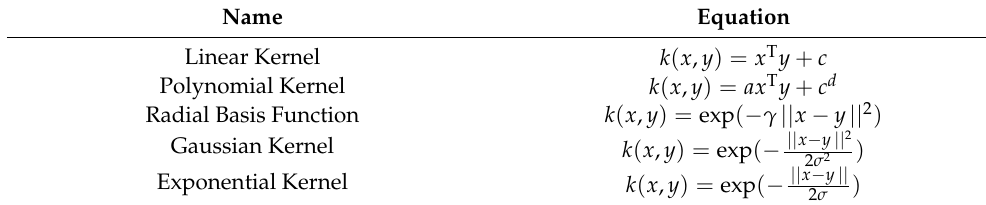
Table 1. Some popular kernel functions.